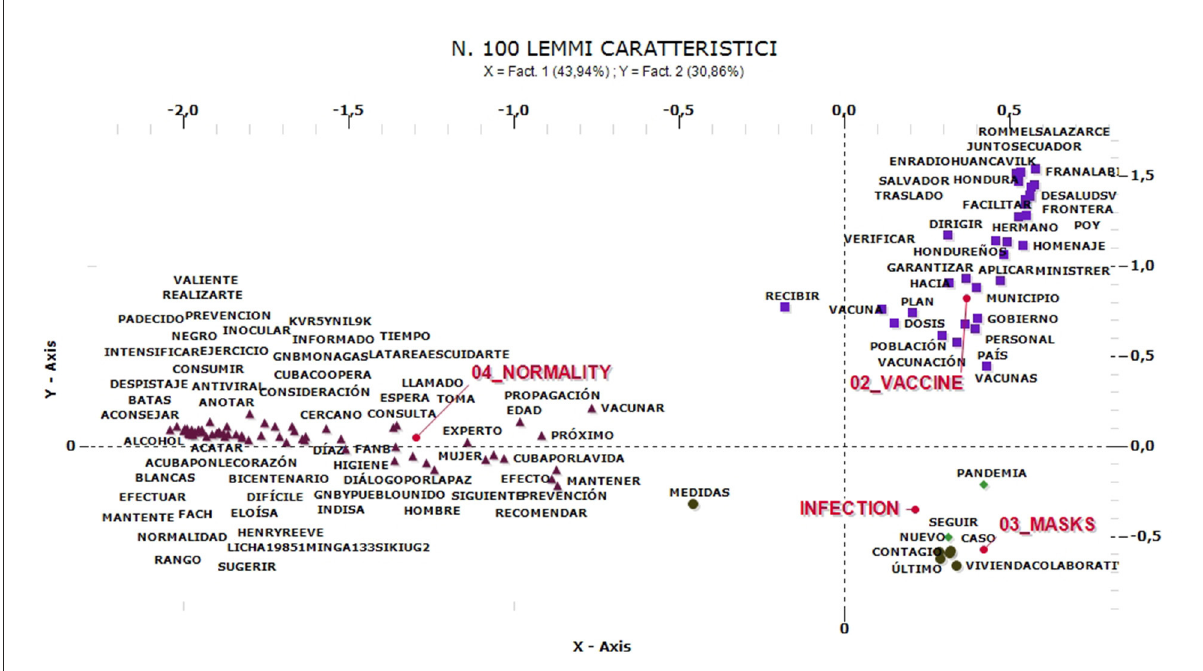
FIGURE12 “COVID-19” comments in Spanish—Multiple Correspondence Analysis.